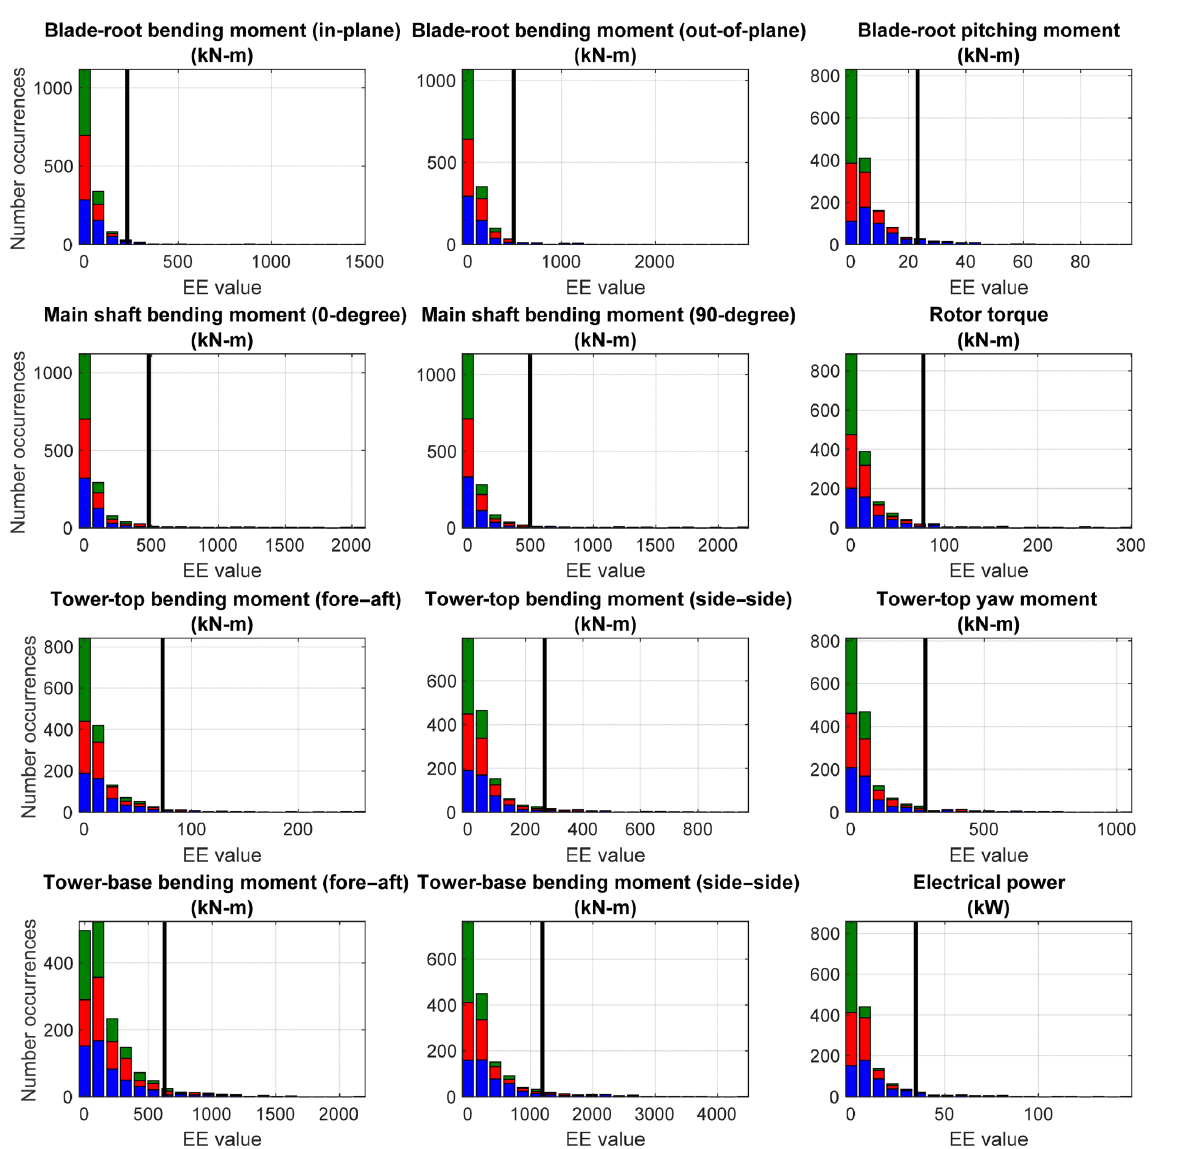
Figure 5. Stacked histogram of the fatigue load EE values for each of the QoIs across all wind speed bins, input parameters, and simulation points. Black line represents the defined threshold by which outliers are counted for each QoI. Color indicates wind speed bin (blue is below-rated speed, red is near-rated speed, green is above-rated speed).